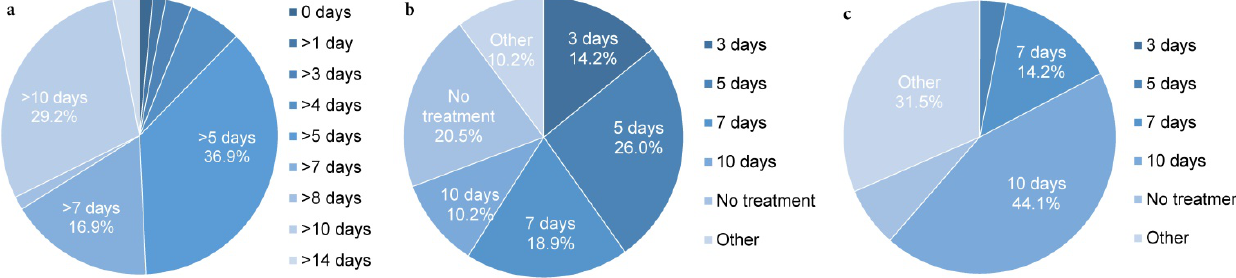
Figure 1. Definition of persistent wound leakage and maximum period of wound leakage before start of (non-)surgical treatment (n=127) 1a. Definition of wound leakage (in days) 1b. Number of days before start non-surgical treatment 1c. Number of days before start surgical treatment